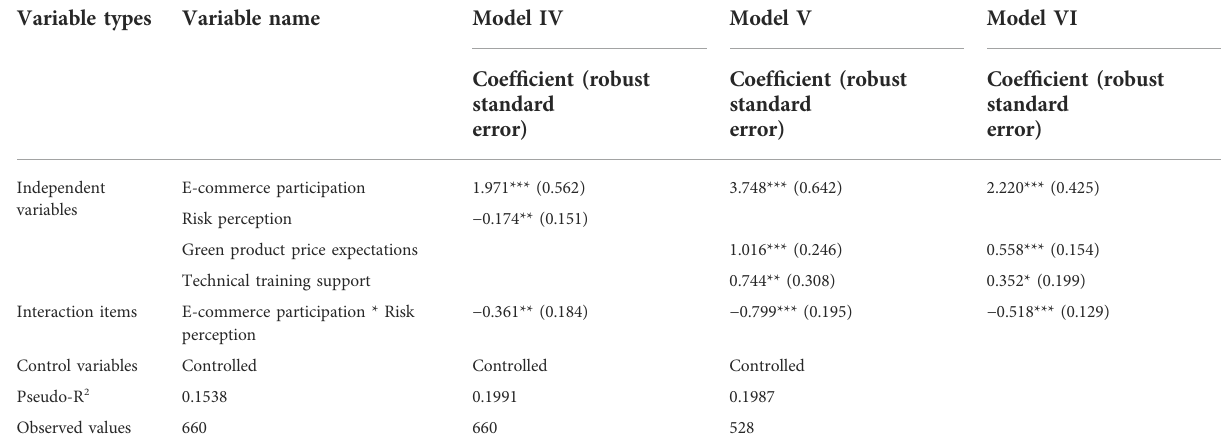
TABLE 8 Analysis of moderating effects of risk